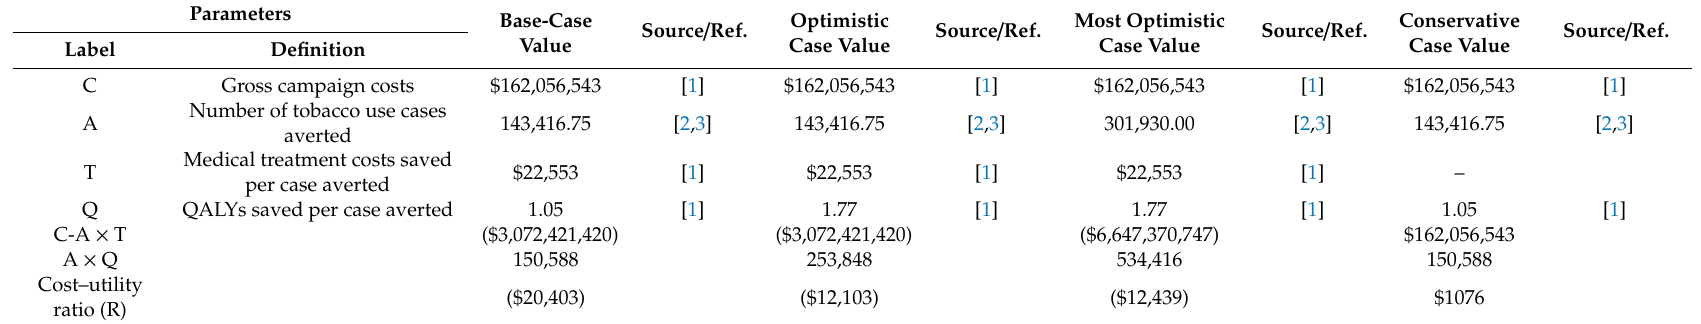
Table 1. Input parameter values and cost-utility analysis of truth ® campaign. QUALY: quality-adjusted